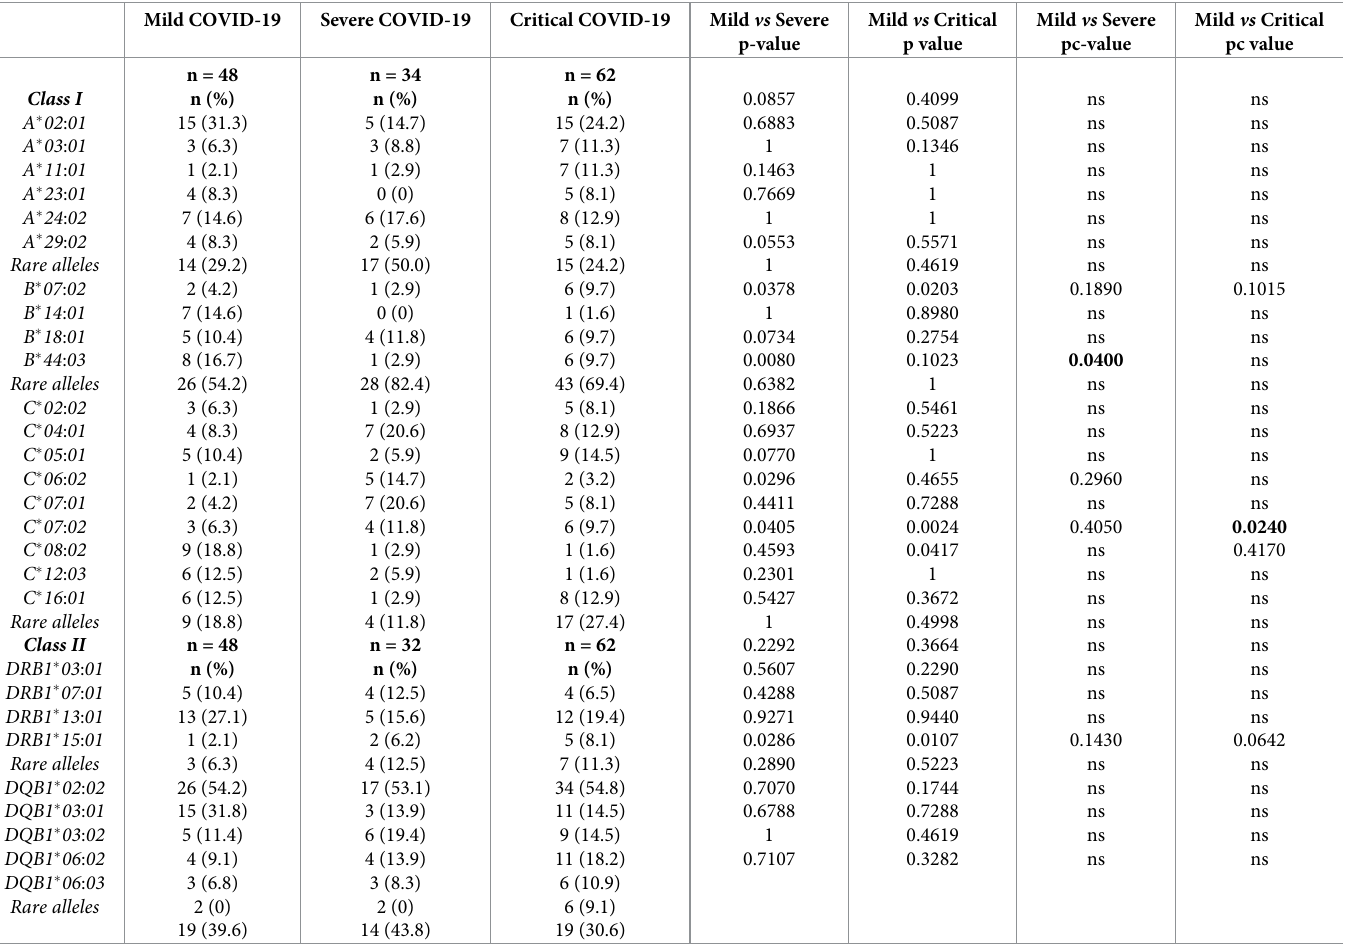
Table 2. HLA class I and II allele frequencies in individuals with mild, severe and critical COVID-19 who were recruited for this pilot study. The statistical signifi- cance of the comparisons between the allele frequencies of groups of individuals with severe and critical COVID-19 and the group of individuals with mild COVID-19 was calculated using Fisher’s exact test or chi-square test 2x2. Significance levels were corrected by Bonferroni correction. Significant pc < 0.05 are highlighted in bold